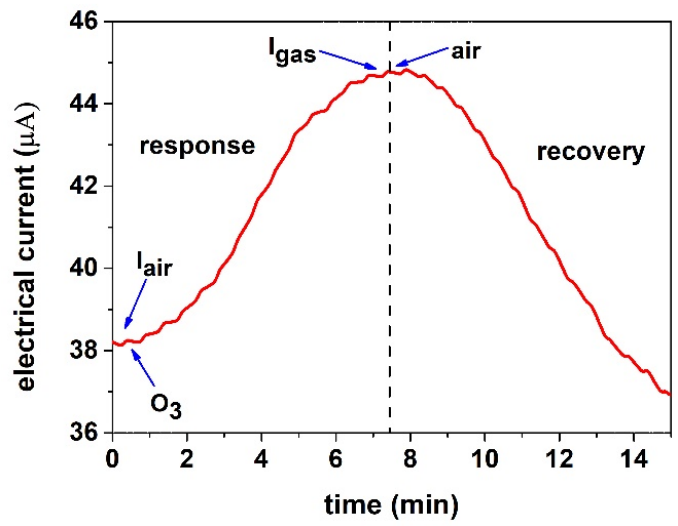
Figure 1. Typical sensing measurement of an O 3 -synthetic air cycle. All measurements were taken under the room relative humidity (RH) which was about